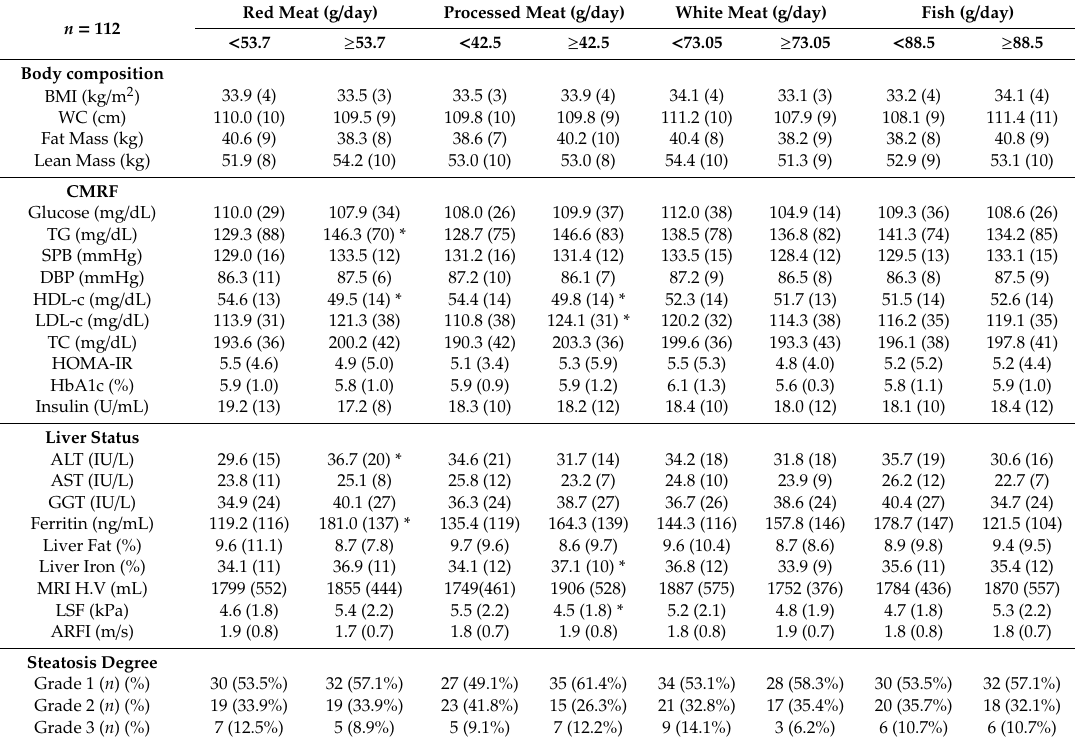
Table 1. Descriptive characteristics of study participants according to the median of animal protein